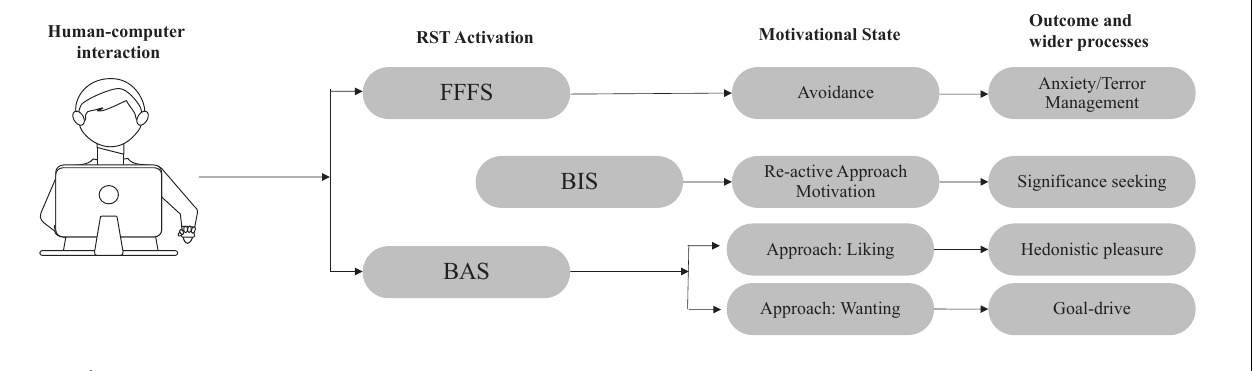
is being repelled from the material, driven by FFFS